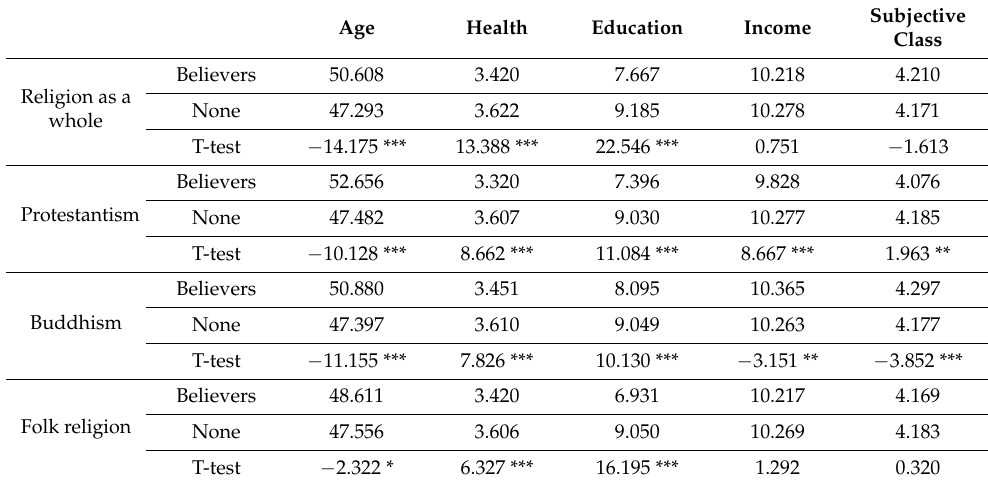
Table 3. Bivariate analysis of the “Five types”